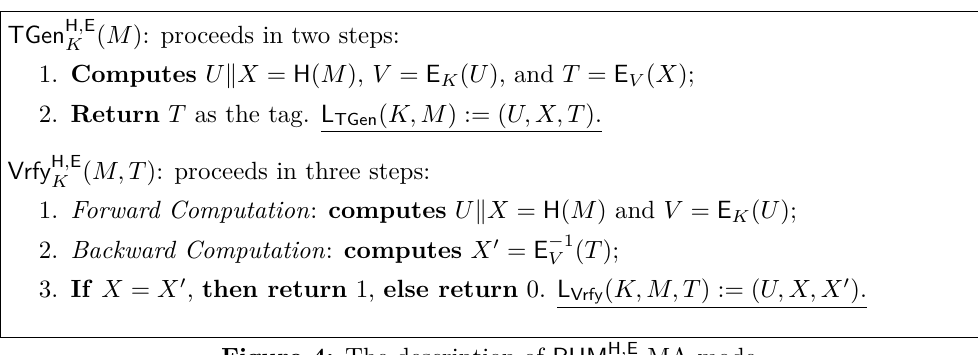
Figure 4: The description of RHM H , E MA